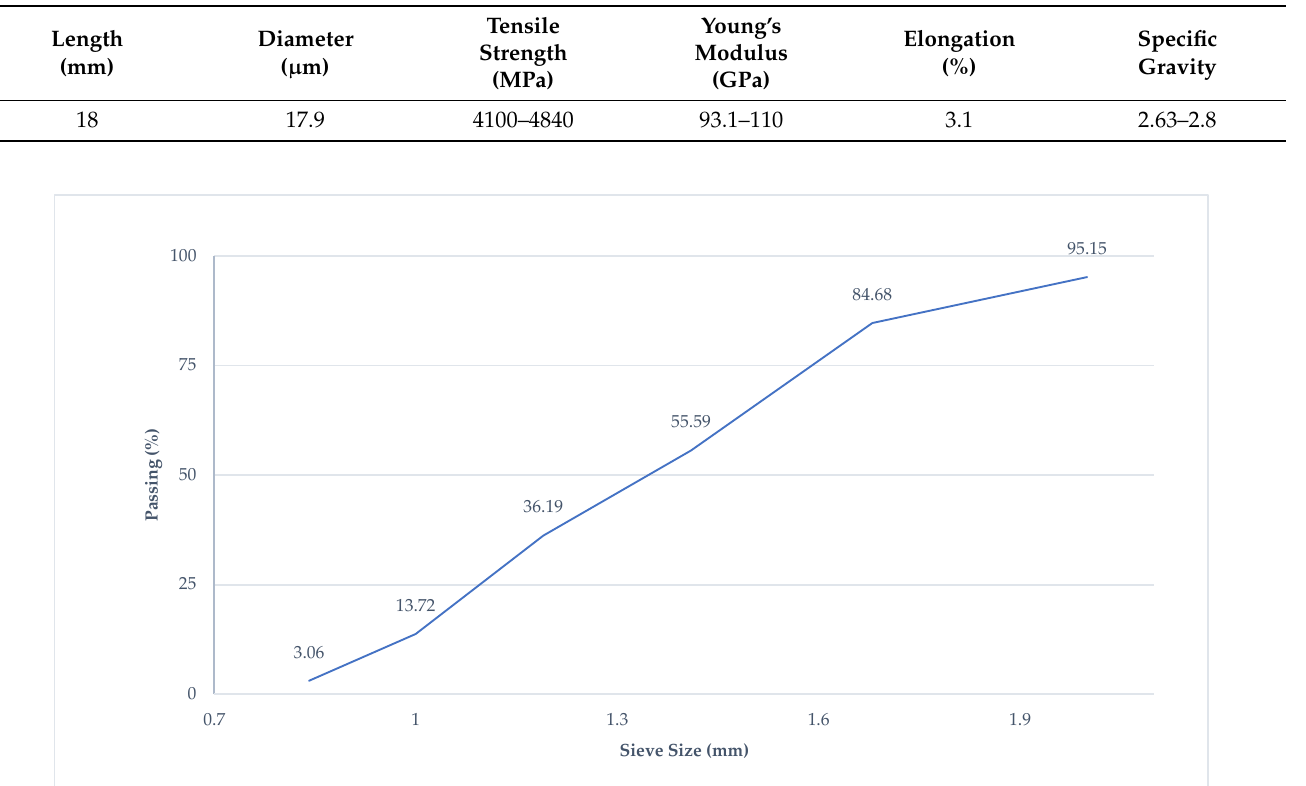
Figure 2. Granulometric Curves of Coarse Aggregates.